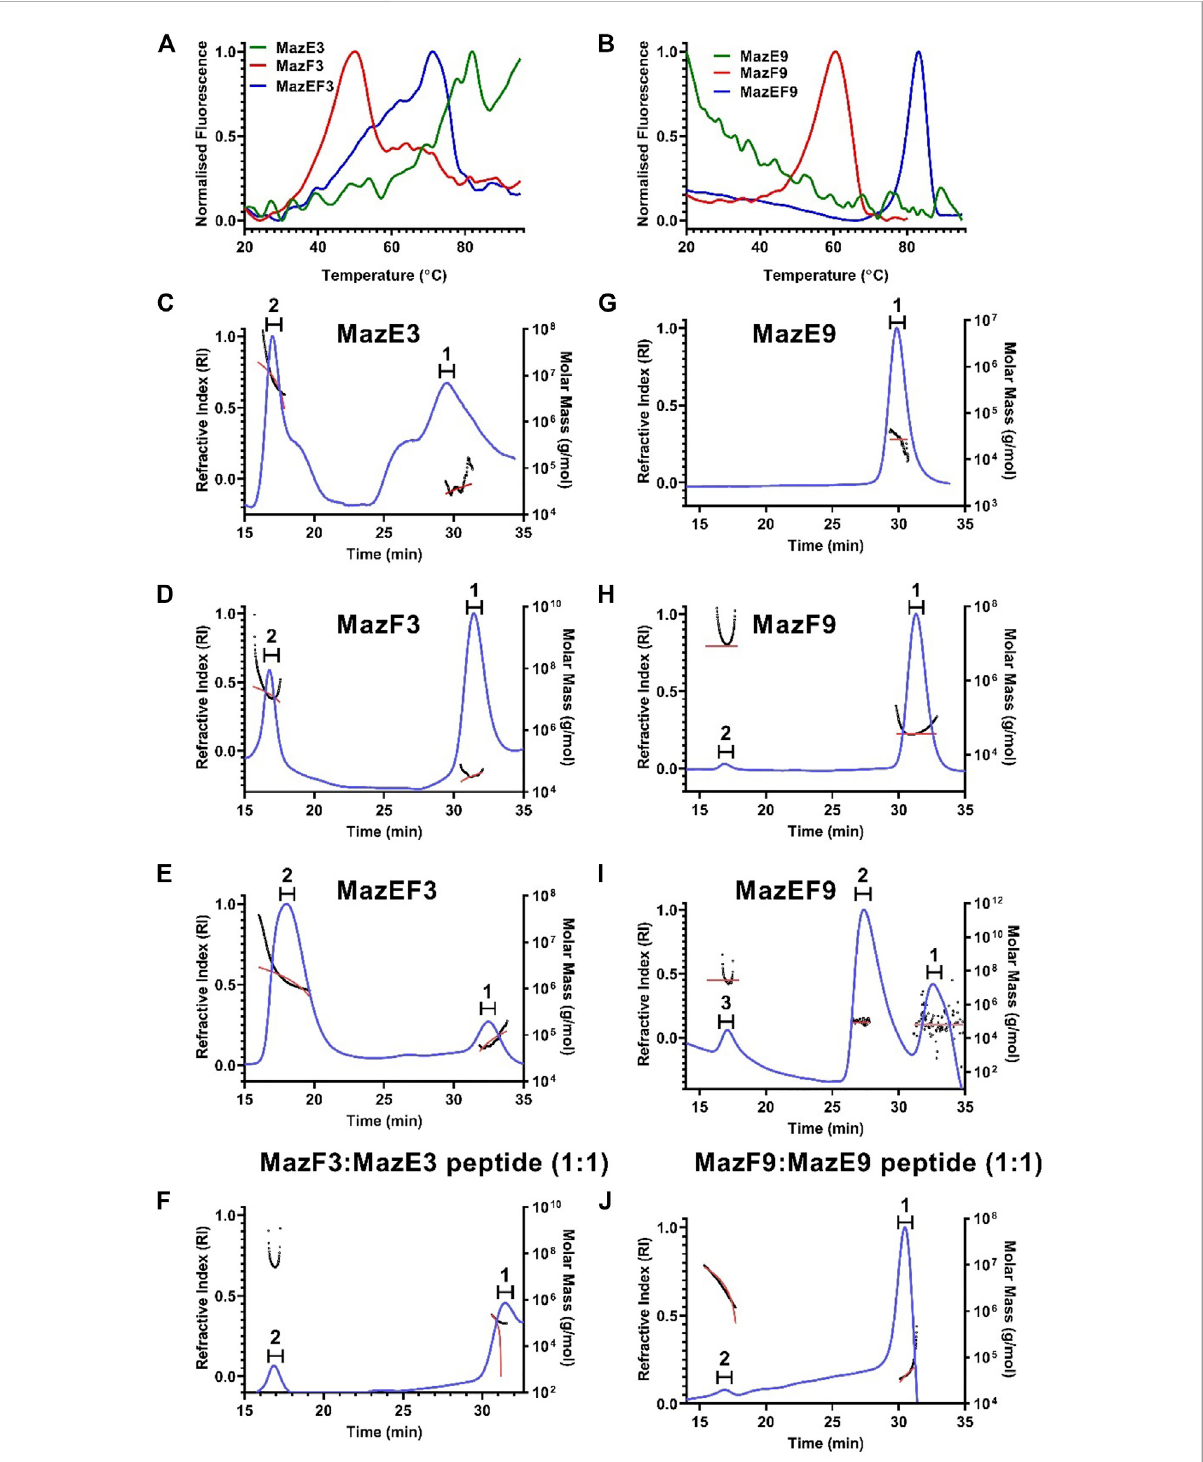
FIGURE 1 Biophysical characterisation of the MazEF3 and MazEF9 TA systems. (A,B) Thermal unfolding pro fi les of 10 µM of MazEF3, MazEF9 complexes, MazE3, MazE9 antitoxins and MazF3, MazF9 toxins were carried out using nanoDSF. First derivatives of thermal unfolding pro fi le of (A) puri fi ed MazEF3 complex (blue), MazE3 antitoxin (green) and MazF3 toxin (red), and (B) puri fi ed MazEF9 complex (blue), MazE9 antitoxin (green) and MazF9 toxin (red). (C – J) Oligomeric stoichiometry analysis of the MazEF3 and MazEF9 TA systems by SEC MALS. Traces for refractive index are shown in blue. The molar mass and fi ts of all traces are plotted as a function of elution time as approximately horizontal red and black lines,